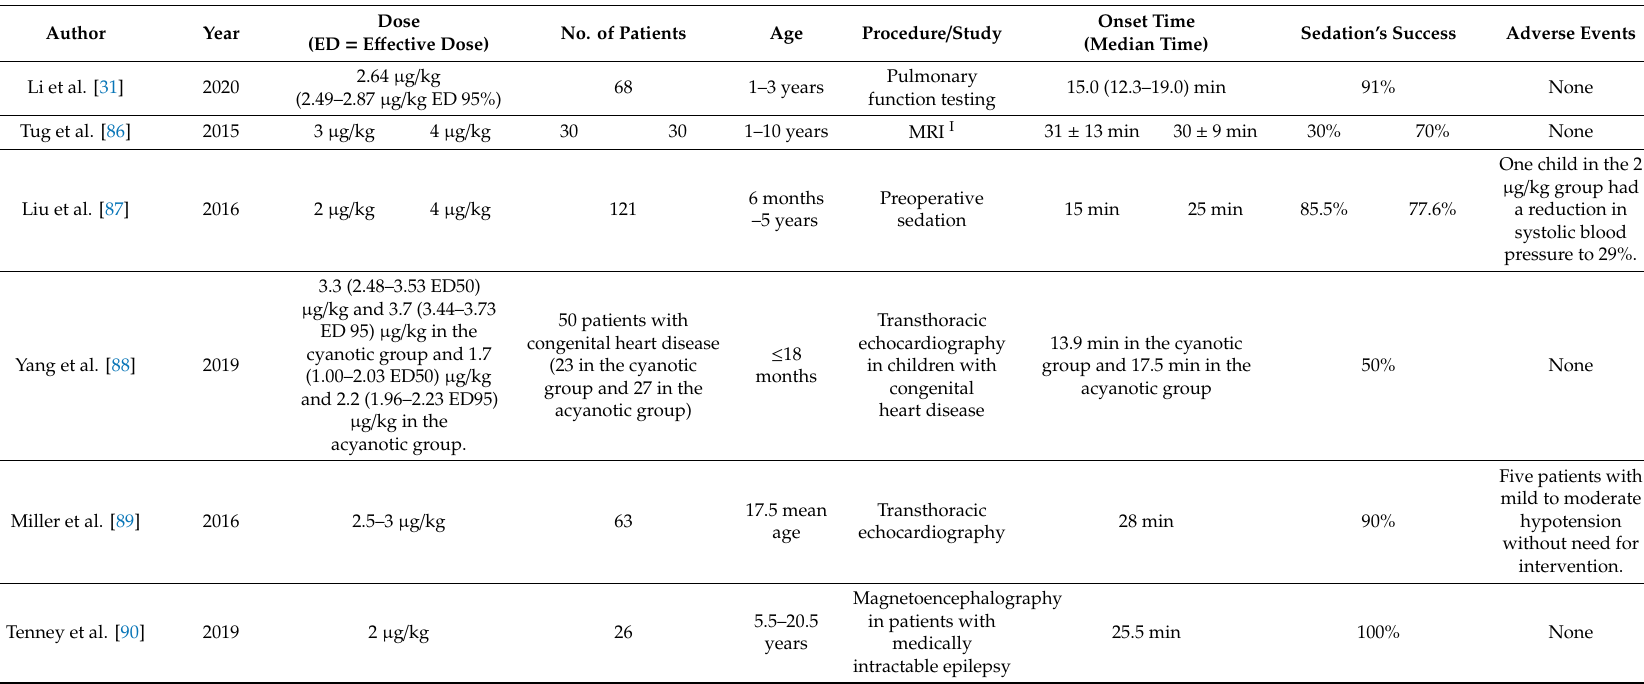
Table 1. Characteristics of dose-finding studies in specific